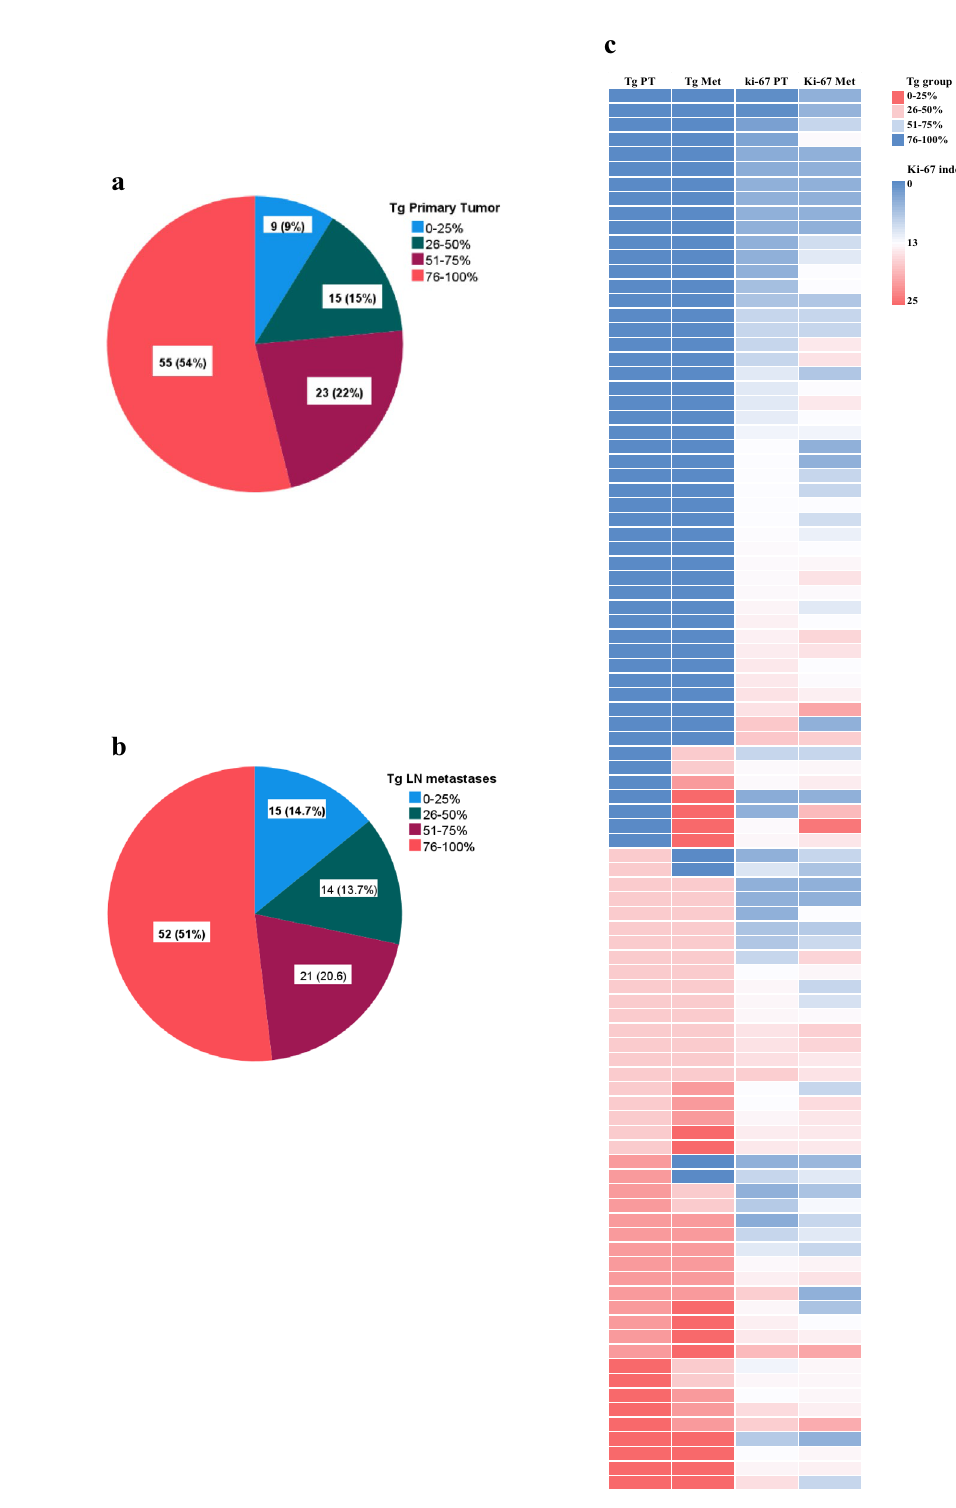
Figure 3. G -graph ( a and b ) and heat map ( c ) illustrate the distribution of thyroglobulin expression in primary papillary thyroid cancer and their paired lymph node